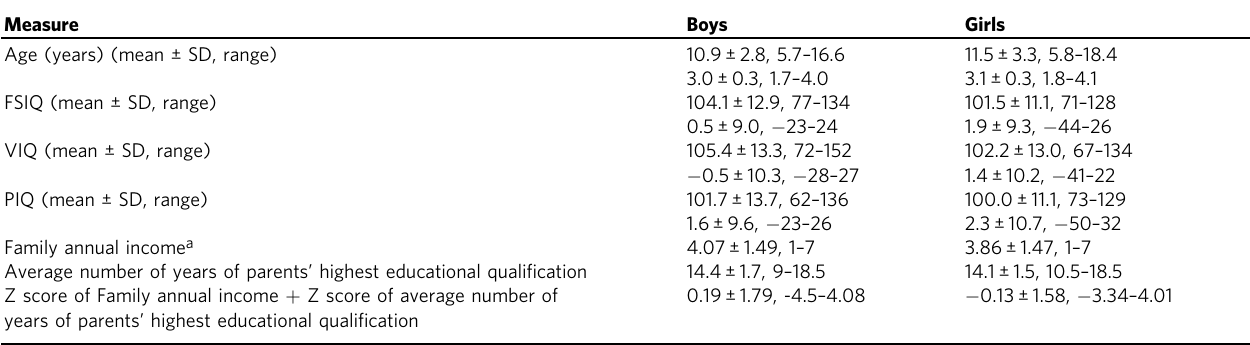
Table 1 Psychological characteristics of the study participants (mean ± SD, range) in the cross-sectional (138 boys and 147 girls) and longitudinal imaging analyses (117 boys and 110